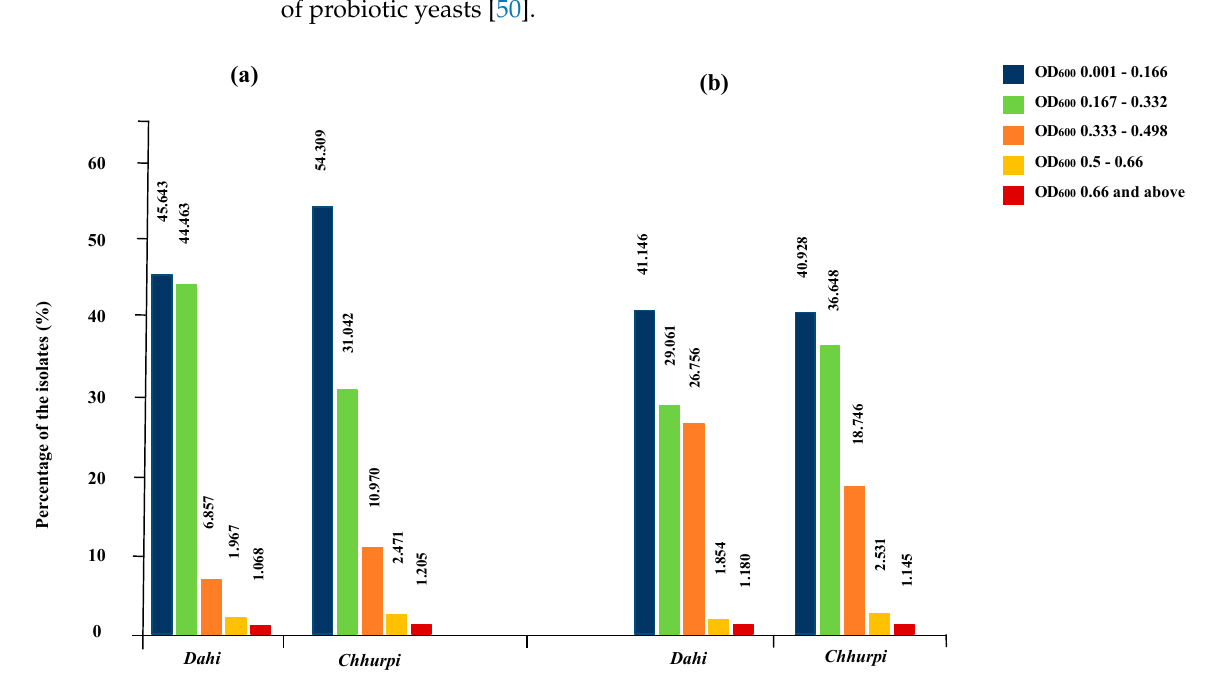
Figure 2. Screening of survival percentages of years isolated from Dahi and Chhurpi intended as ( a ) low acid tolerance (pH = 2), and ( b ) bile tolerance (0.3% w/v ). Twenty screened probiotic yeasts were phenotypically tested and were tentatively iden- tified as up to four major genera as Saccharomyces , Pichia , Kluyveromyces and Debaryomyces (Table